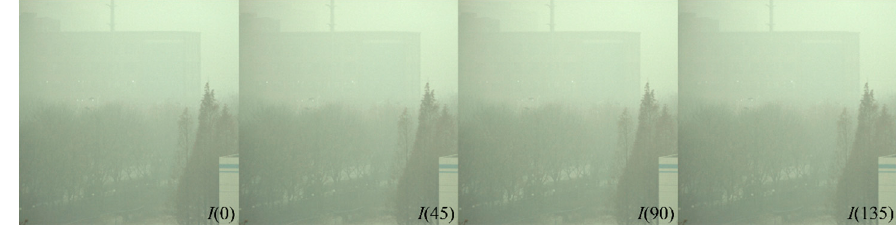
Figure 2. Original captured polarized images in very severe hazy weather.